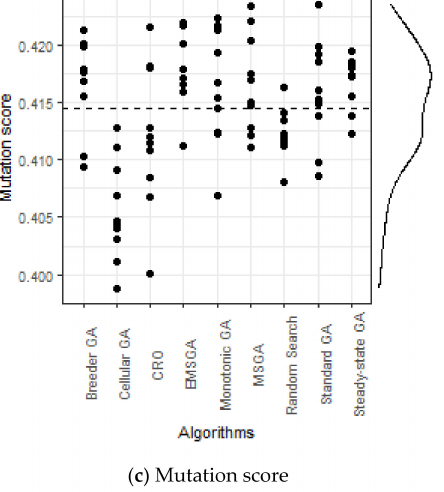
Figure 5. Average values of metrics for each algorithm.